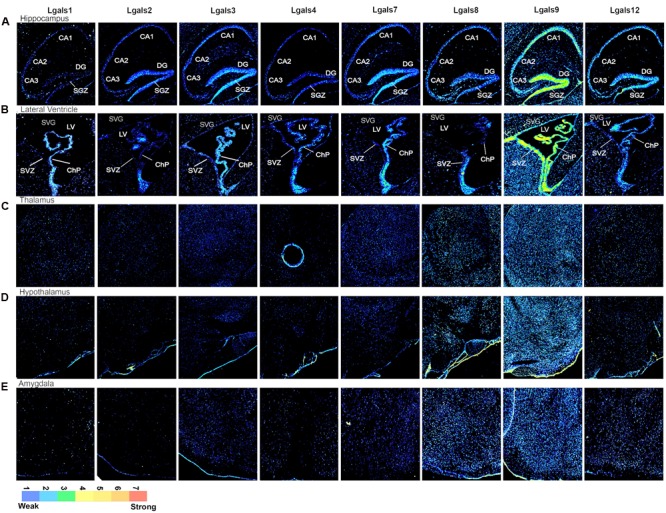
Galectins expression in mouse Hippocampus, Sub-Ventricular Zone, Thalamus, Hypothalamus and Amygdala (A) Expression profile of galectins in hippocampus. CA1, Cornu Ammonis1; CA2, Cornu Ammonis2; CA3, Cornu Ammonis3; DG, dentate gyrus; SGZ, sub granular zone. (B) Expression profile of galectins in lateral ventricle (LV). SVZ, sub ventricular zone; ChP, choroid plexus. (C) Expression profile of galectin in thalamus. (D) Expression profile of galectins in hypothalamus. (E) Expression profile of galectins in amygdala.